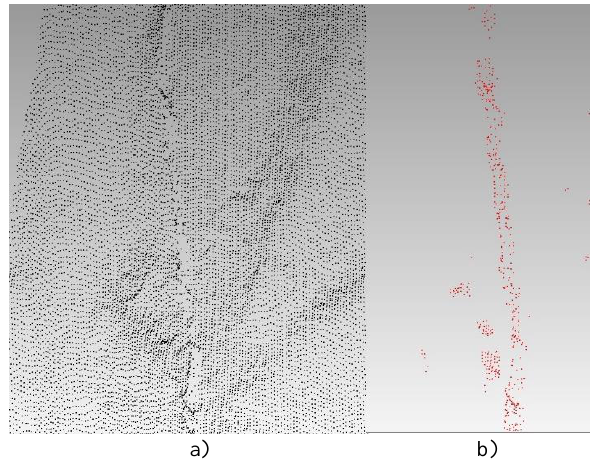
Figure 7. a) Detail of Figure 6 with complex surfaces